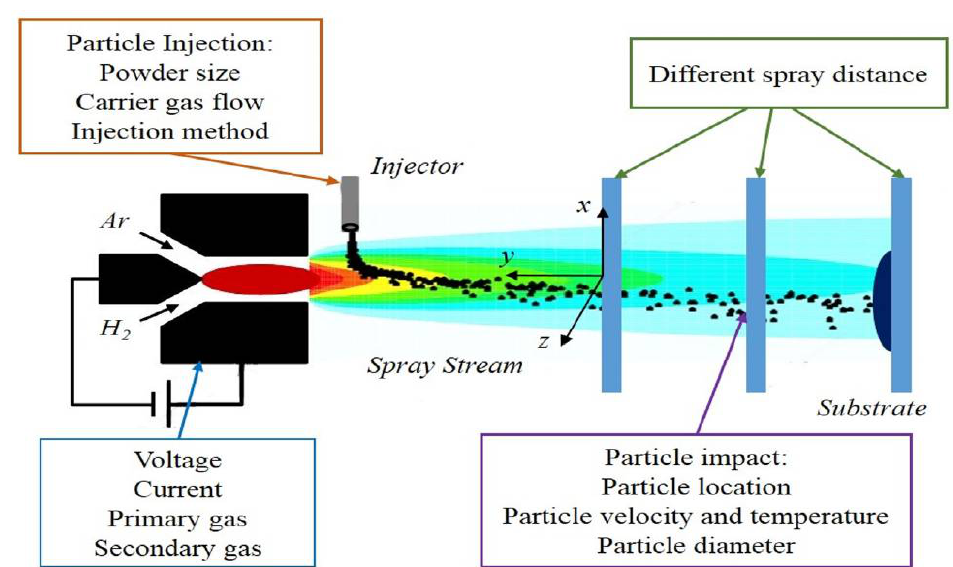
Figure 10. Themost important controller parameters used in APS [41].